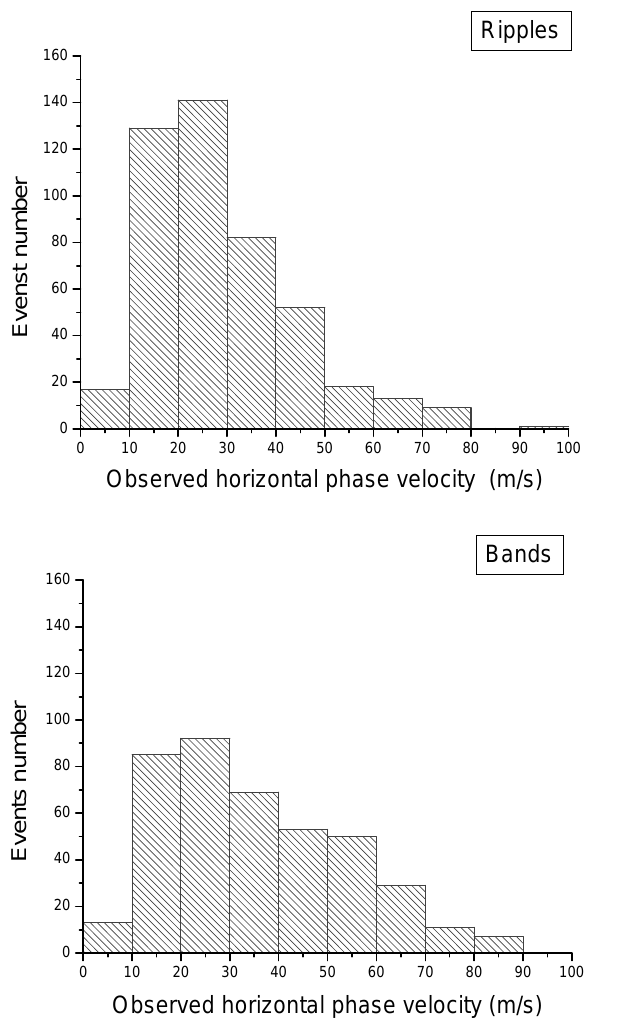
Fig. 5. Histogram of the observed horizontal phase velocity for bands and ripples binned in 10m/s intervals.